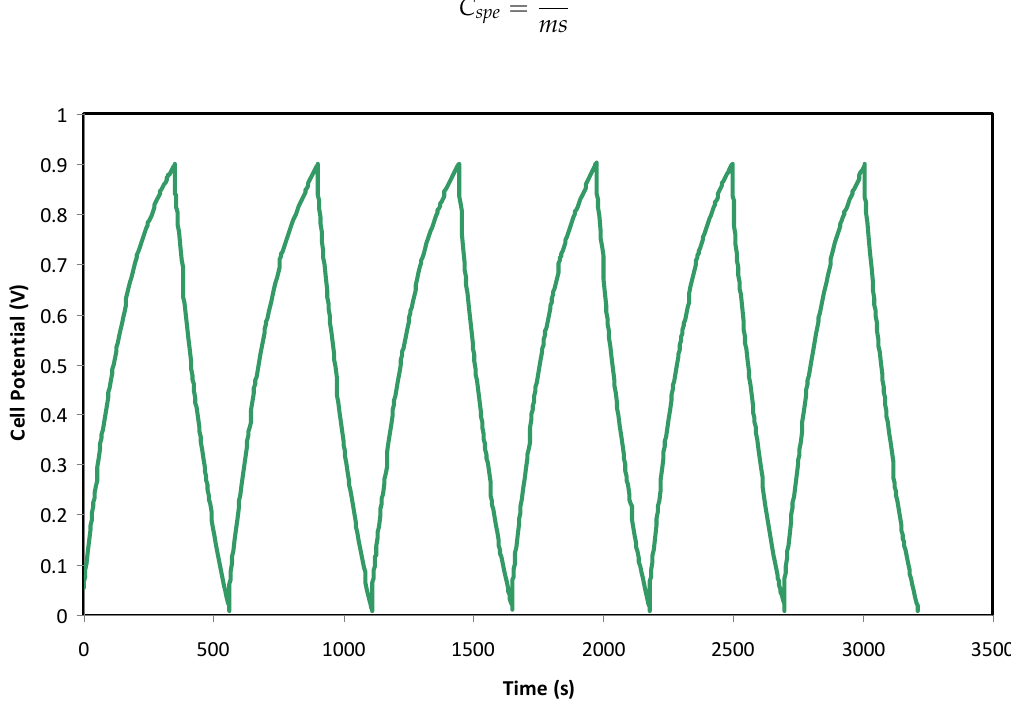
Figure 7. Charge-discharge profiles of the fabricated EDLC at selected cycles.